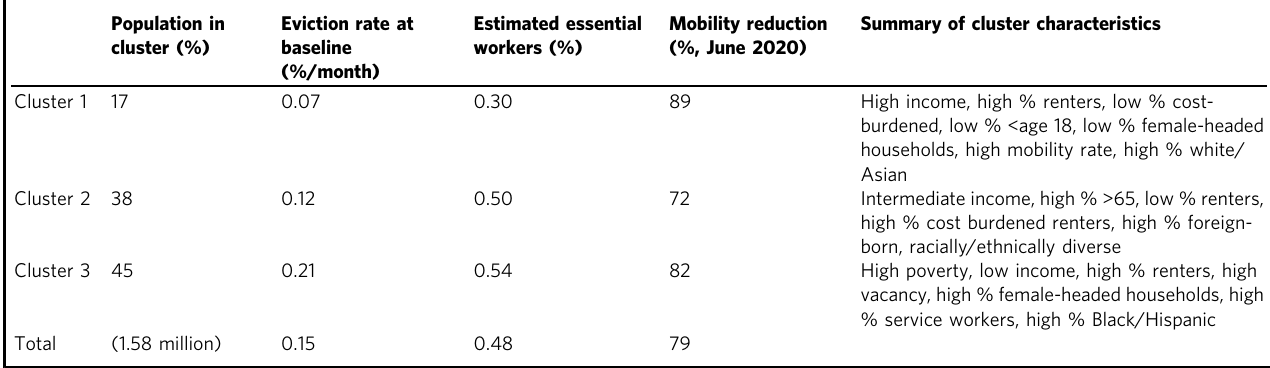
Table 2 Properties of neighborhood clusters in Philadelphia used in